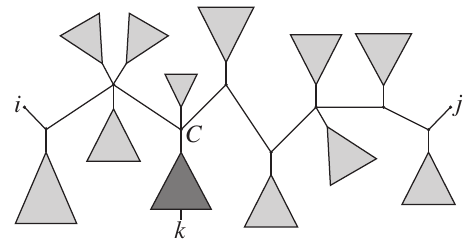
Figure 8. Handling all trees hanging off the path from i to j